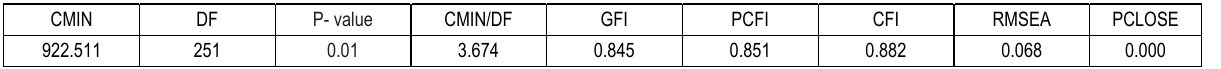
Table 4. Index of the fit of the model